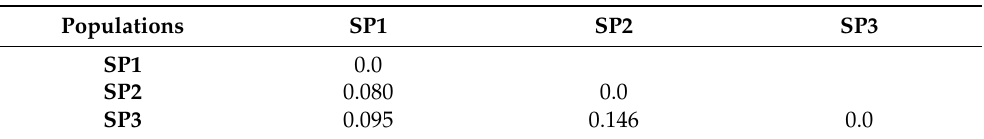
Table 5. Pairwise population differentiation (F ST value) of 163 Mithun, 10 gaur, and 25 Tho-tho cattle germplasm at subpopulation